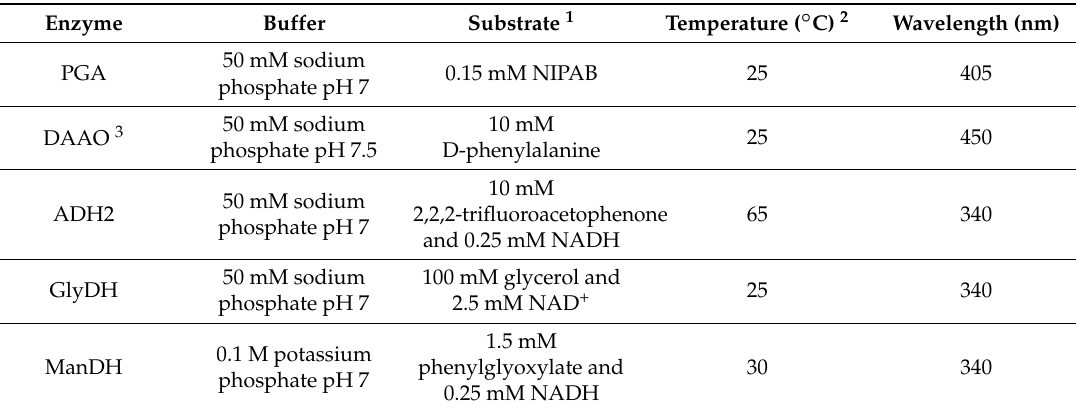
Table 4. Summary of continuous enzymatic